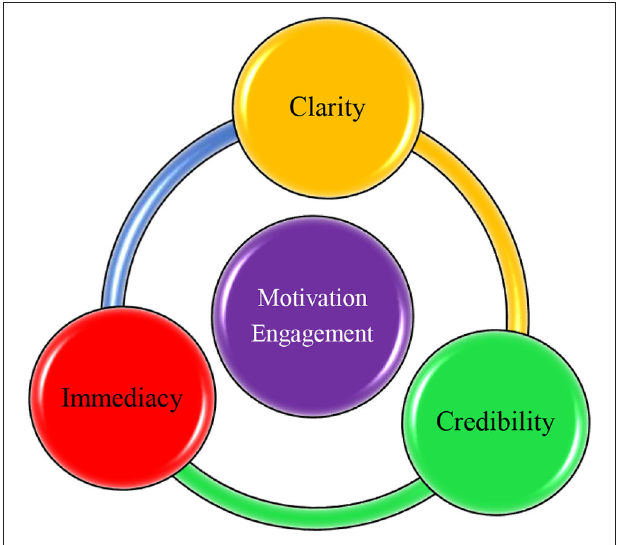
FIGURE 1 | A visual model of the interpersonal communication behaviors of teacher and the outcomes of